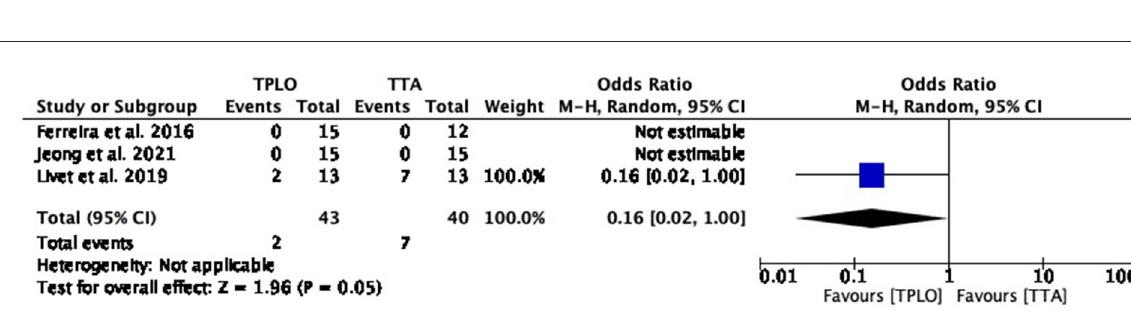
FIGURE3 Forest plot comparing TPLO vs. TTA. Odd ratios (95% CI) of surgical site infection as a complication for TPLO and TTA.